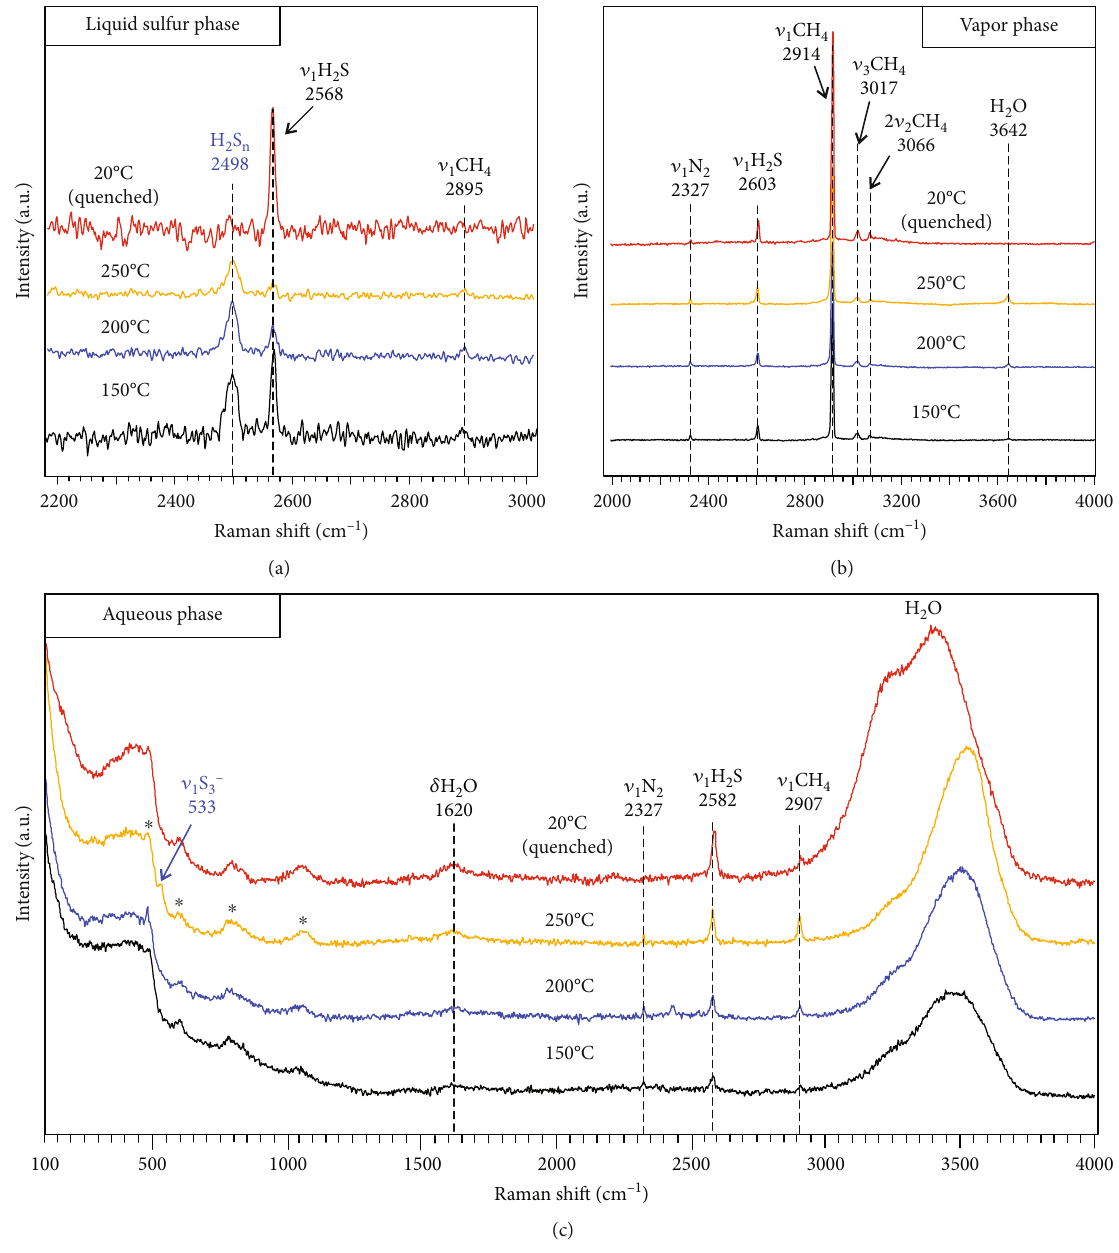
– H S – CH O system at 150 – 250 ° C. (a) Liquid S phase, (b) vapor phase, and (c) aqueous phase. 2 4 2